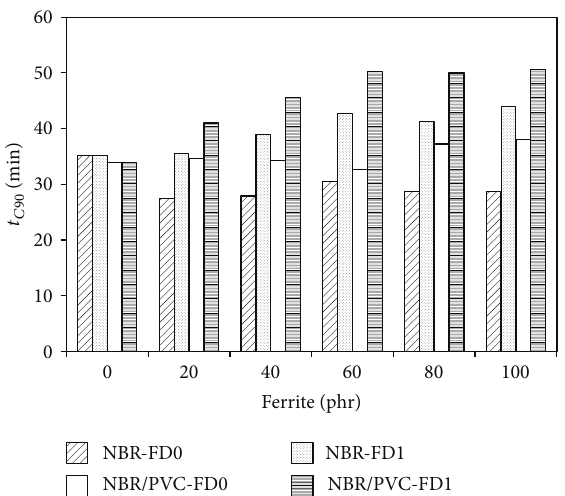
Figure 4: Influence of ferrites content on chemical cross-link den- sity ] ch of